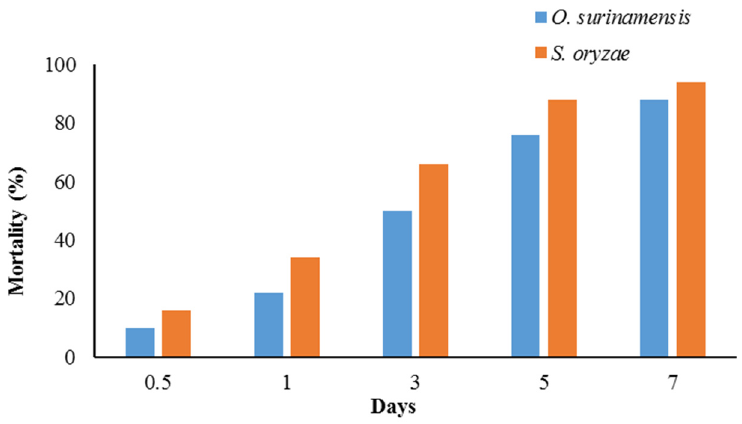
Figure 6. Evolution of pest mortality (%) exposed to 3 µL/L air of T. kotschyanus essential oil.